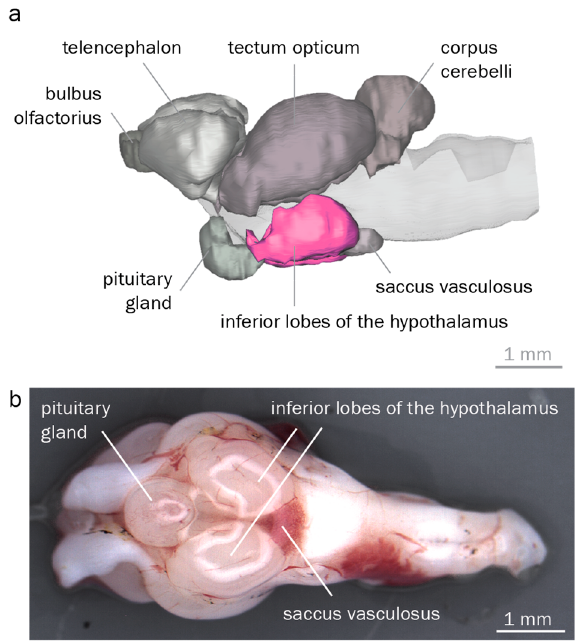
Figure 4. Round goby brain morphology. ( a ). 3D reconstruction of a round goby brain, lateral view. Inferior hypothalamic lobes are highlighted in pink. ( b ). Dissected round goby brain, ventral view. Anterior is to the left in both panels.